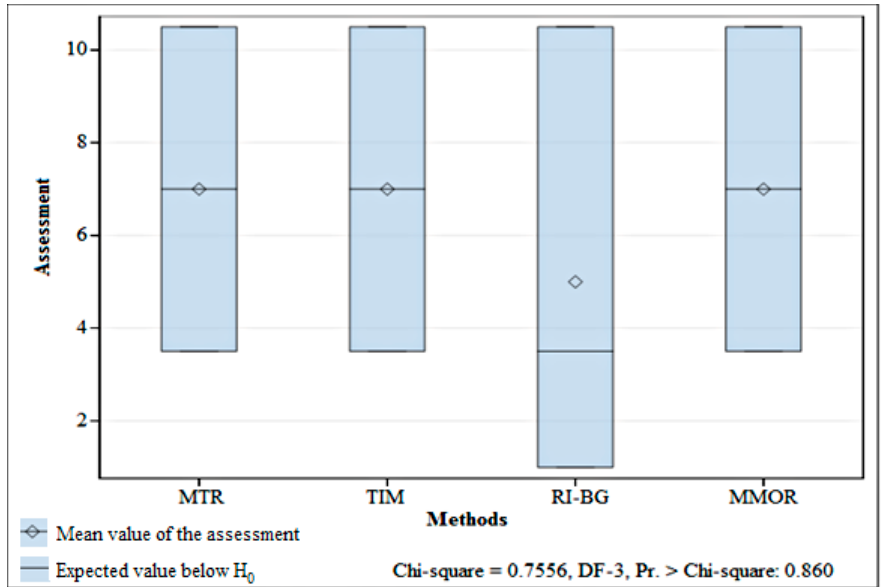
Figure 5. Distribution of Wilcoxon’s assessment for results obtained using the four methods (Kruskall–Wallis test). Table 19. Wilcoxon’s assessment (sums of ranks) for results obtained using the four methods.